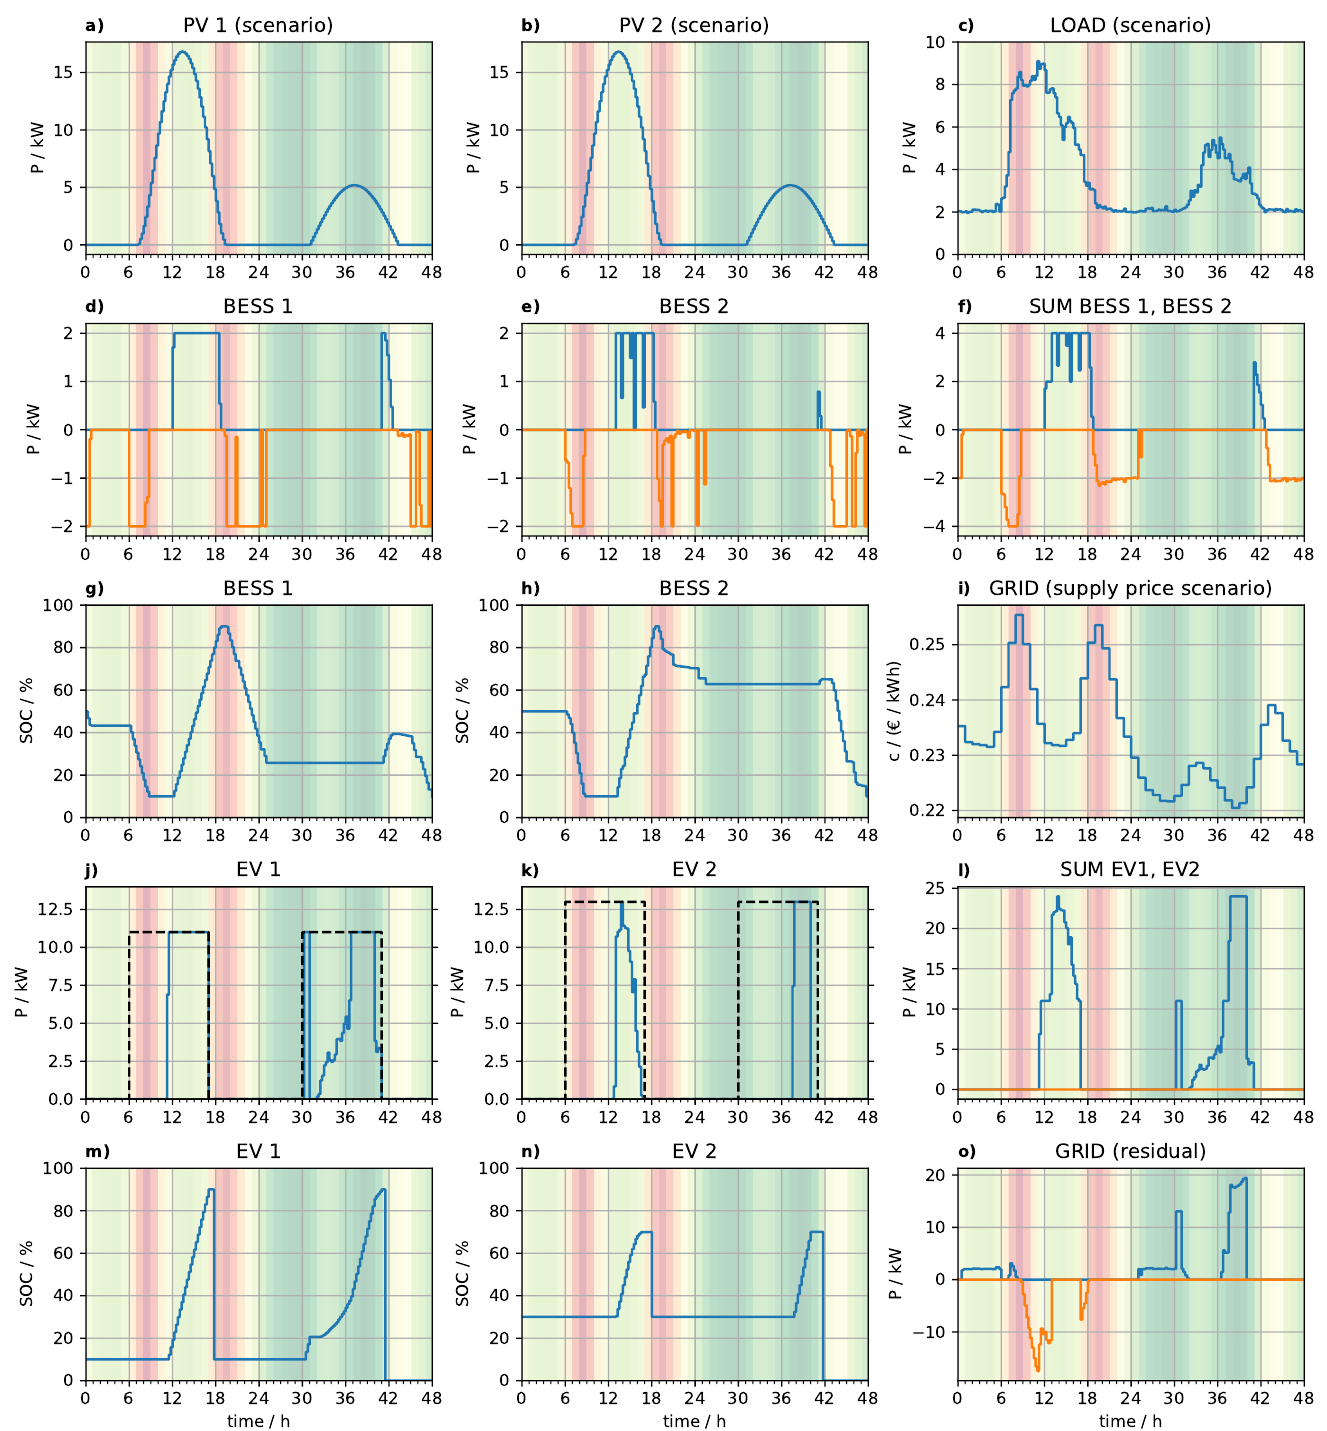
Figure 6. Results of an exemplary optimisation. The number of modular components (PVs, BESSs, and EVs) is two per category. The predicted PV power of the two plants is depicted in ( a , b ). Subplot ( c ) shows the predicted power demand P l . The charging power (blue) and discharging power (orange) of the two BESSs are shown in subplot ( d , e ). Subplot ( f ) shows the summary charging power (blue) and discharging power (orange) of both BESSs. The resulting SOC is shown in ( g , h ). The grid supply price is plotted in ( i ). The background of all subplots is color-coded with the grid supply price ( i ), green meaning low prices, and red meaning high prices. The charging power (solid line) and availability (dashed line) of the EVs are plotted in ( j , k ). Subplot ( l ) shows the summary charging power of the EVs. The resulting SOCs are shown in ( m , n ). Finally, the grid residual power (supply: blue, feed-in: orange) is shown in subplot ( o